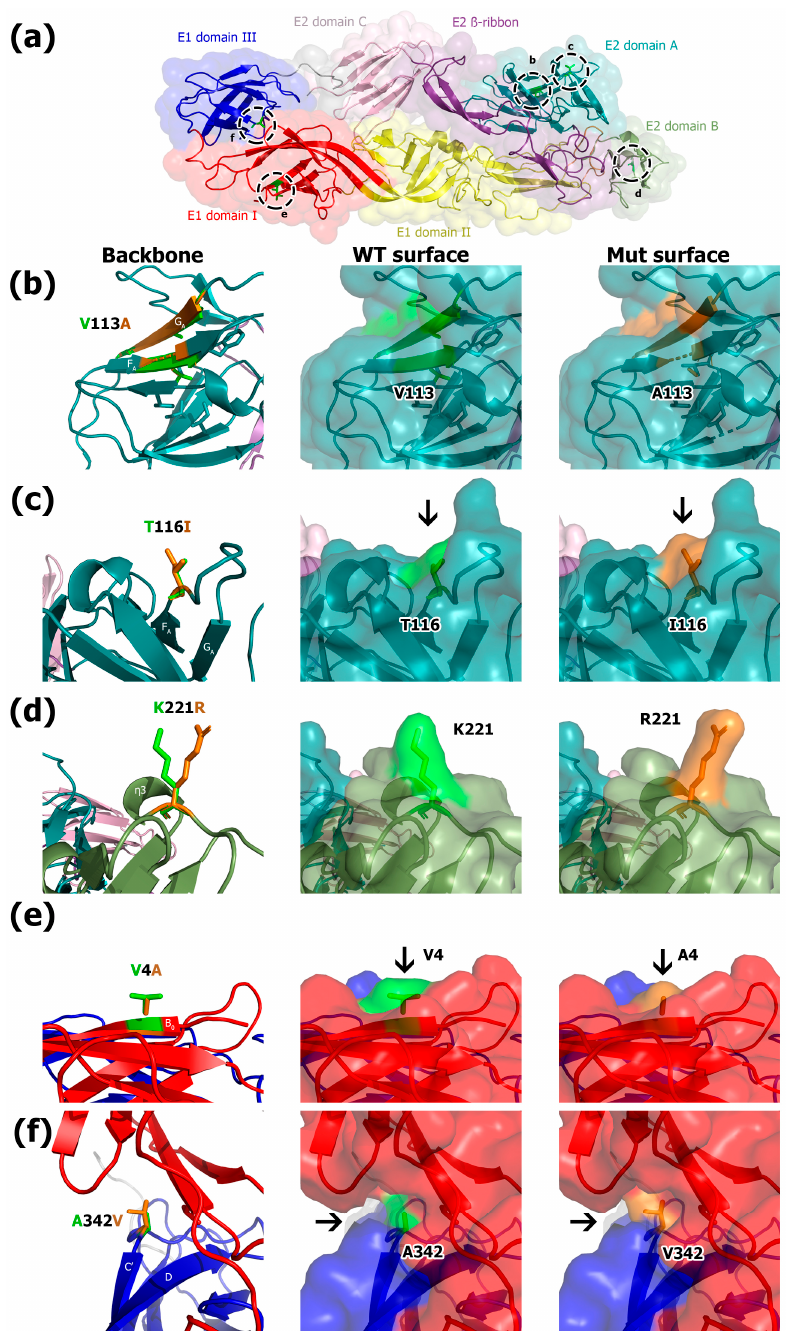
Figure 3. Molecular model of CHIKV envelope proteins. ( a ) Structure of E1 and E2 CHIKV proteins. E1 domains I, II, and III are shown in red, yellow and blue, respectively. E2 domain A is colored teal, B dark green, C pink, and ß-ribbon dark purple. The five non-synonymous mutations are shown in a discontinuous black circle. ( b ) E2 V113A mutation present in isolates from Southern Chiapas in 2014. ( c ) E2 T116I mutation present in isolate TA689. ( d ) E2 K221R mutation present in isolate TA689. ( e ) E1 V4A mutation present in isolate TA702. ( f ) E1 A342V mutation present in isolate TA725. The wild-type (WT) amino acid is colored lime, and the mutated amino acid is colored orange. The left panel shows the protein backbone. Central and right panels show the protein surface of the WT amino acid and the mutation, respectively. Strand and helixes are indicated in white. Black arrows indicate the change in the protein surface.